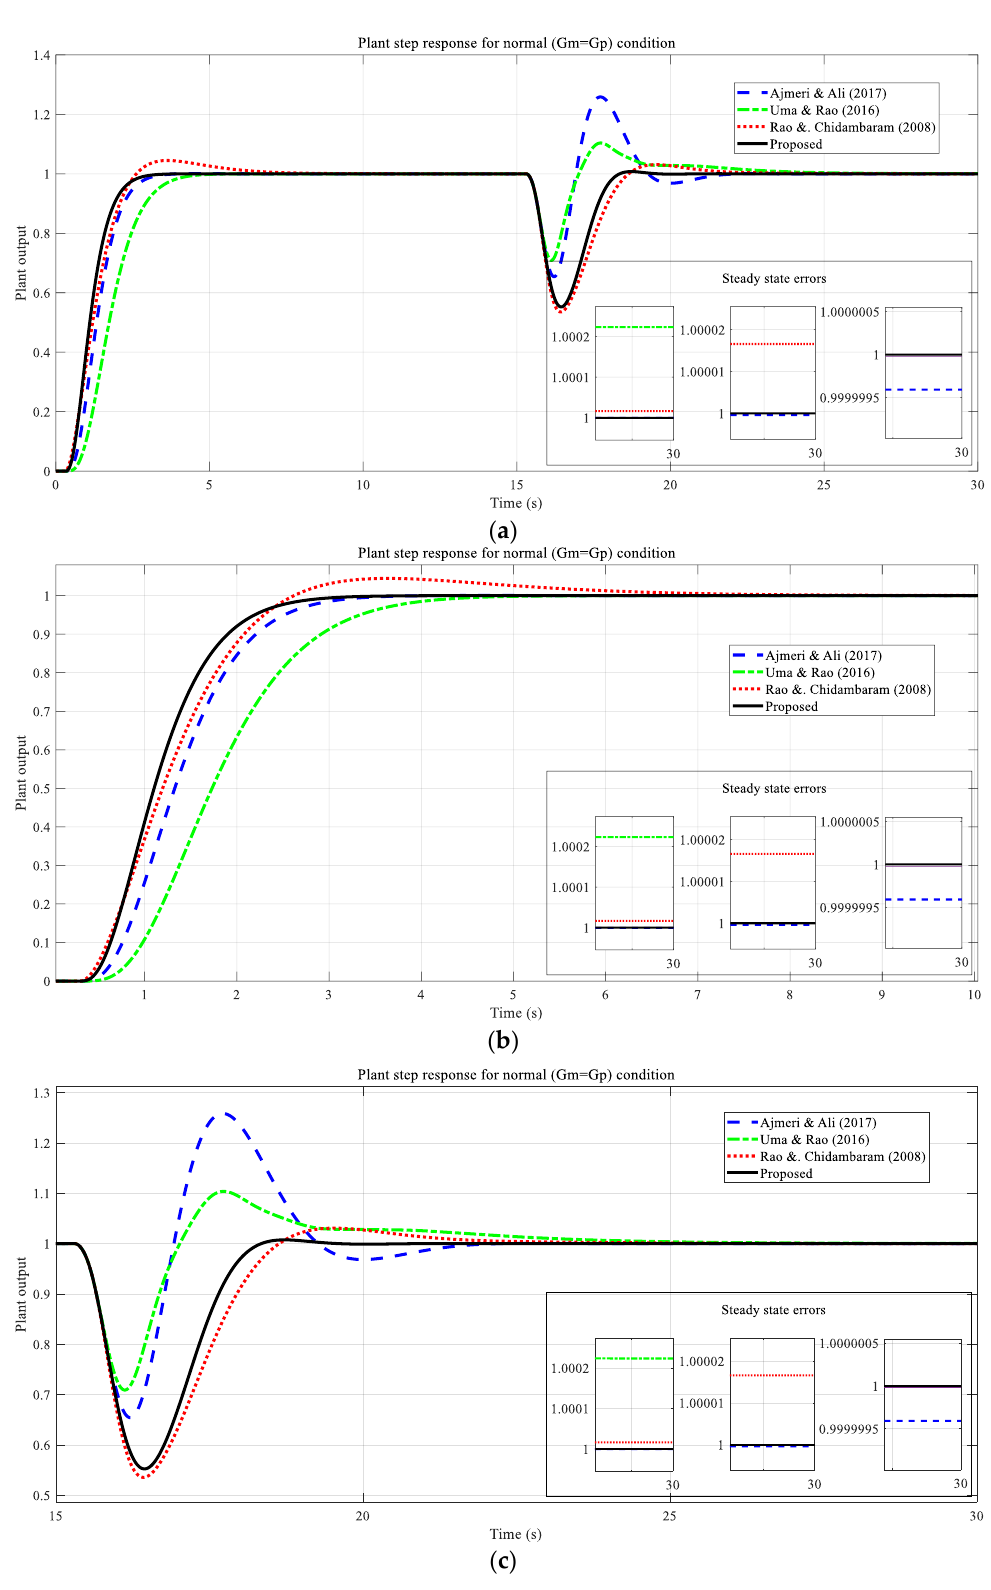
Figure 4. Closed loop performances of the proposed method and other methods for Example 1. ( a ) Set-point tracking and disturbance rejection, ( b ) magnified set-point tracking, and ( c ) magnified disturbance rejection [15,16,18].